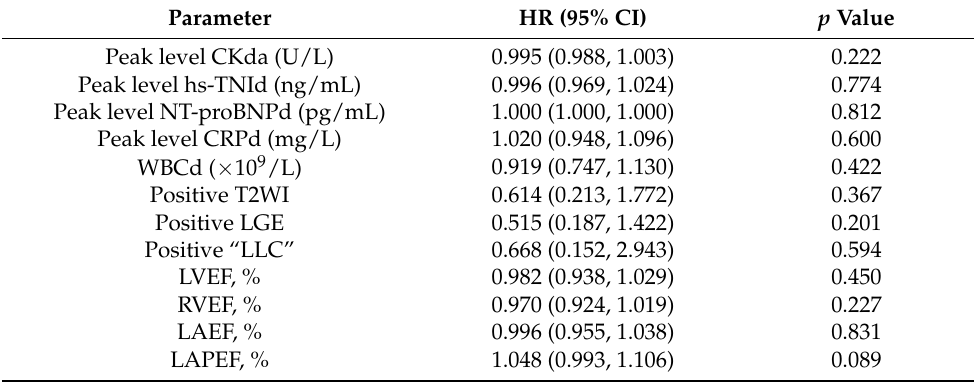
Figure 2. Baseline and 3-month follow-up T2 STIR and LGE images of a 15-year-old man with acute myocarditis. Myocardial edema in the basal ventricular segment of septal wall resolved from baseline (( A ), yellow arrows) to follow-up (( C ), red arrows). However, the LGE persisted ( B , D ). Table 3. Univariable association of initial laboratory findings and CMR parameters with